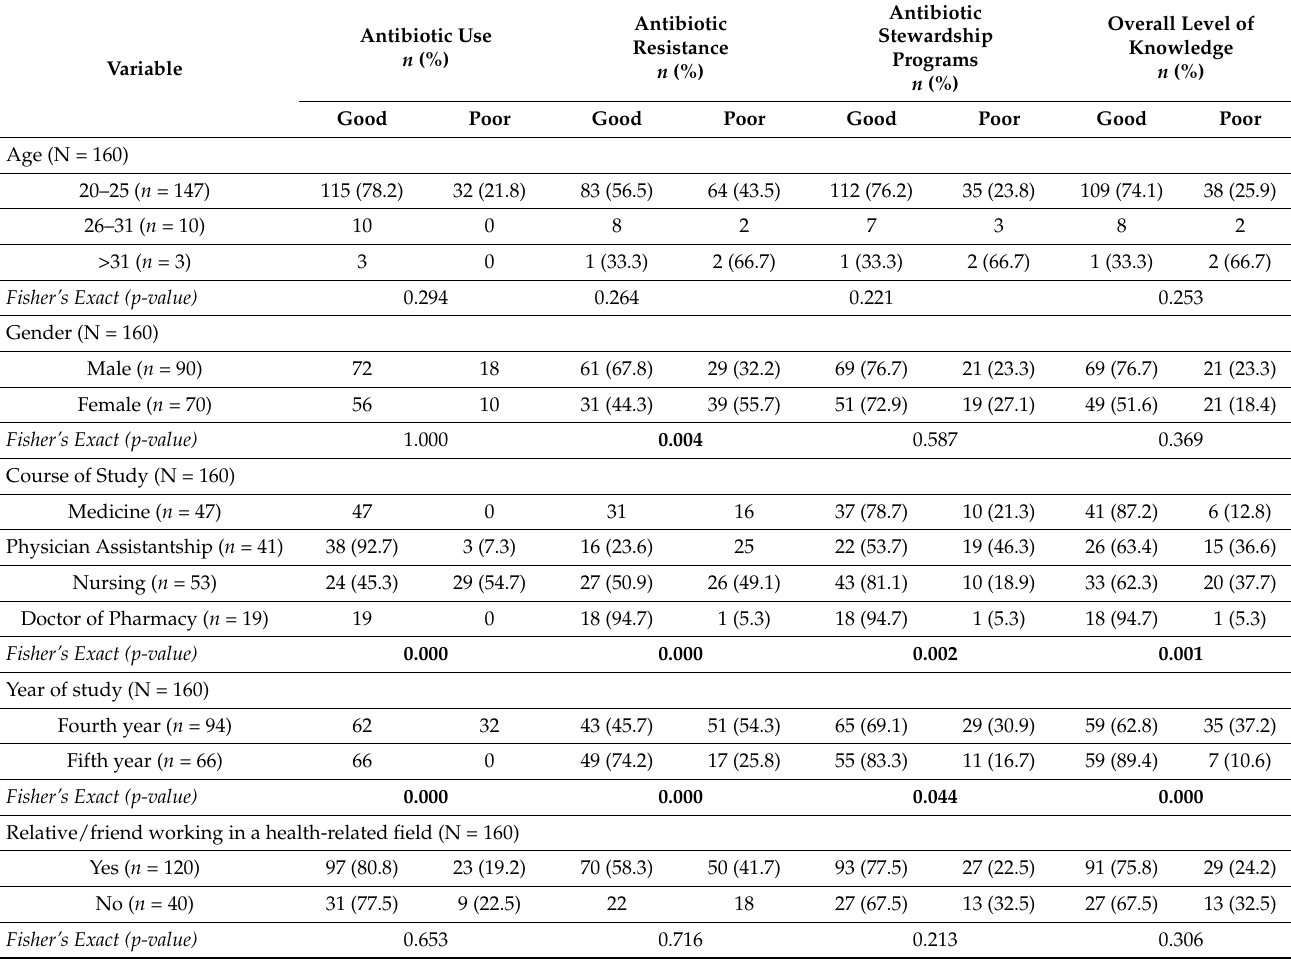
Table 2. Association between socio-demographic characteristics of respondents and their knowledge of antibiotic use, resistance, stewardship and their overall knowledge of